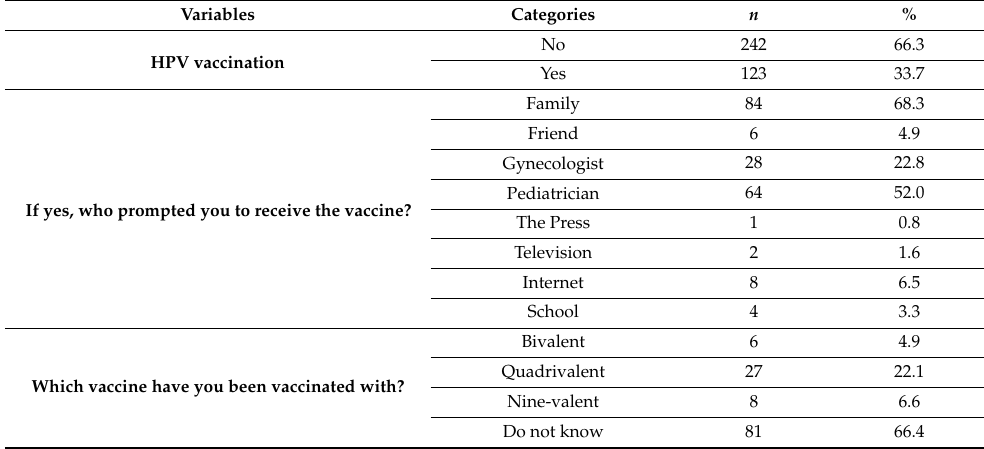
Table 5. HPV vaccination status, choice of HPV vaccination, and reasons for taking the